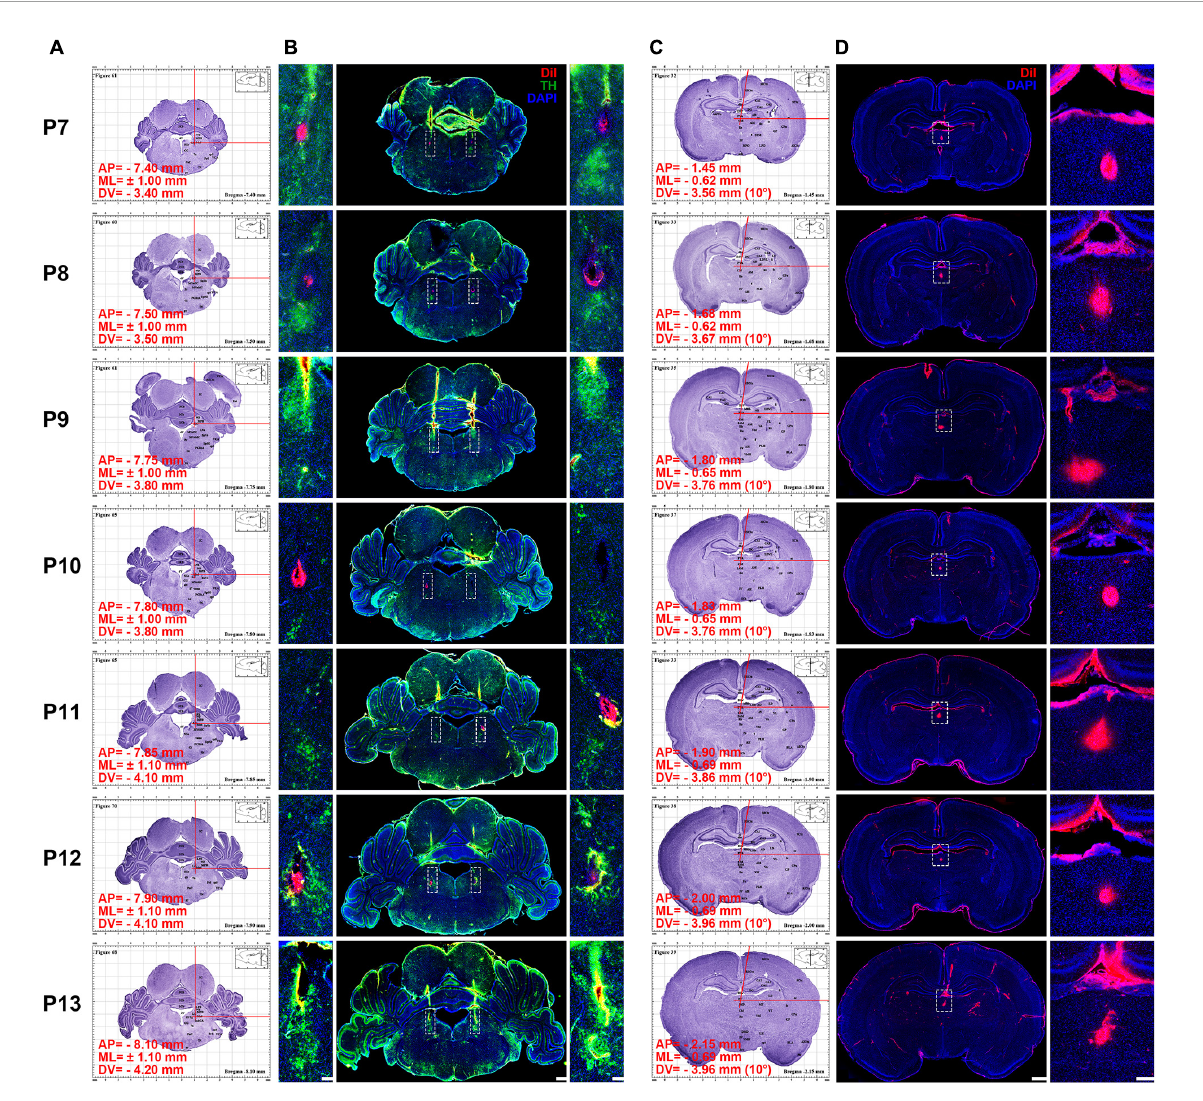
FIGURE3 Using the atlas to calculate and inject DiI into P7–P13 pups’ locus coeruleus LC) and paraventricular thalamic nucleus (PVT). (A) Using the atlas to calculate the coordinates of the LC (see Supplementary materials 1–7 for clear figures). (B) Middle column, coronal section of pups’ brain at the LC stained with DiI (red), tyrosine hydroxylase (TH) (green), and 4 (cid:48) ,6-diamidino-2-phenylindole (DAPI) (blue). Left and right column, magnifying insets in dotted square in the middle column. Bar = 500 µ m (middle column), bar = 100 µ m (left and right column). (C) Using the atlas to calculate the coordinates of the PVT (see Supplementary materials 1–7 for clear figures). In order to avoid the damage of the superior sagittal sinus during the surgery, an angle of 10 ◦ to the right is used in the calculation (see Supplementary materials 1–7 for clear figures). (D) Left column, coronal section of pups’ brain at the PVT stained with DiI (red) and DAPI (blue). Right, the enlarged images of the white dotted box in the left column, bar = 1,000 µ m (left column), bar = 100 µ m (right column). The red words in (A,C) show the coordinates of the DiI injection